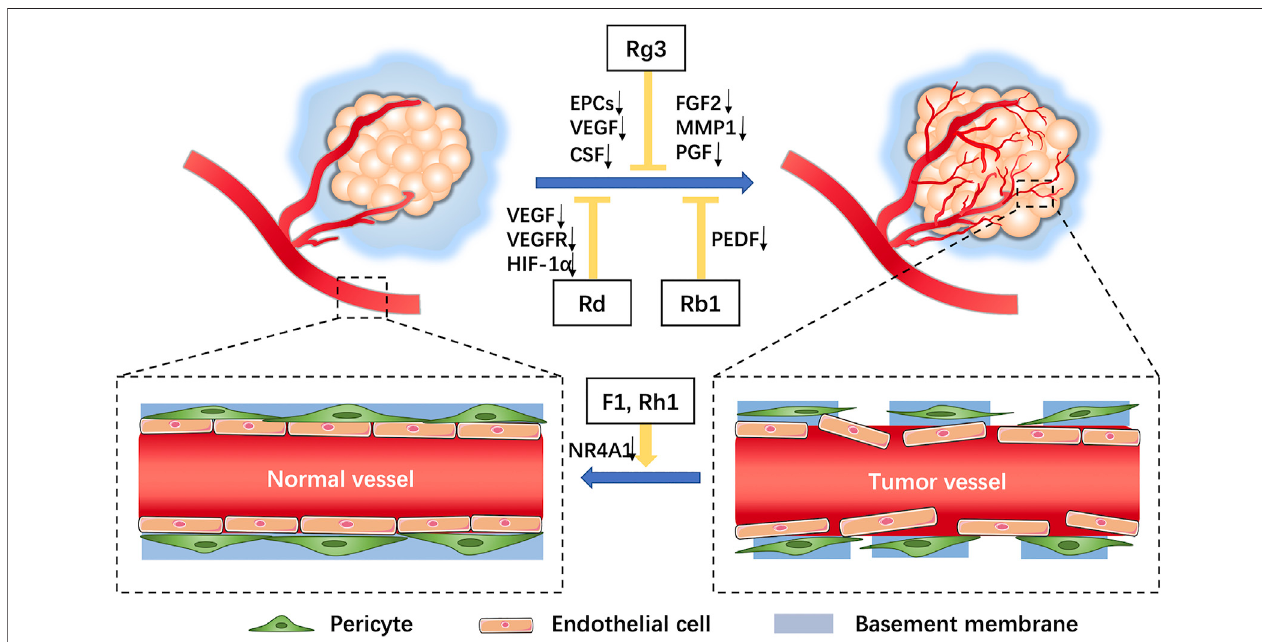
FIGURE 1 | Characteristics of tumor vessels and roles of ginsenosides on tumor angiogenesis. In the tumor microenvironment, tumor blood vessels comprise a tortuous,over-branched,anddisorderedvascularnetworkstructurewithincreasedvascularpermeability(increasedendothelialcellgaps,lossofpericytecoverage,and incomplete basement membrane). Ginsenosides can inhibit effects of angiogenic factors on tumor angiogenesis and facilitate vascular normalization.